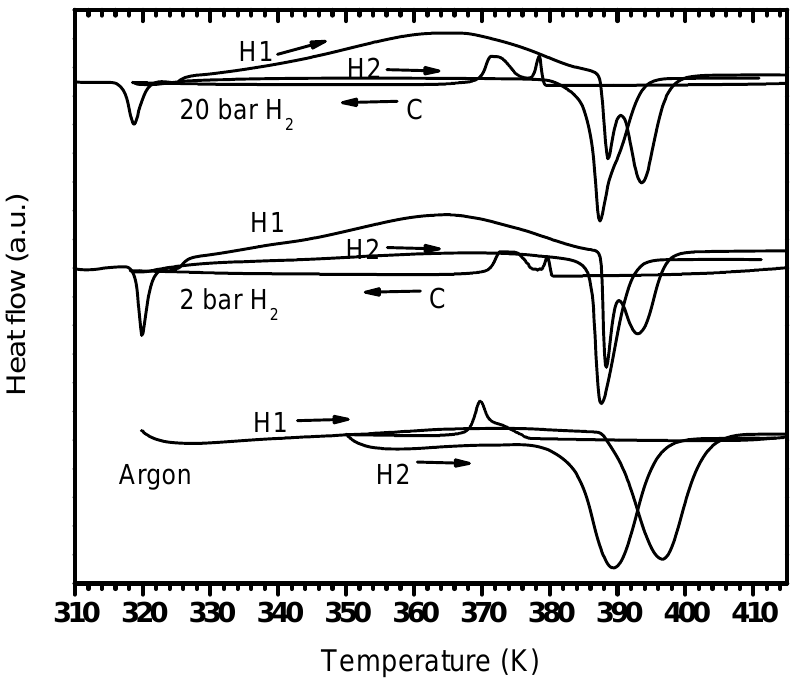
Figure 6. Scanning PDSC traces under argon and hydrogen pressure of one hour